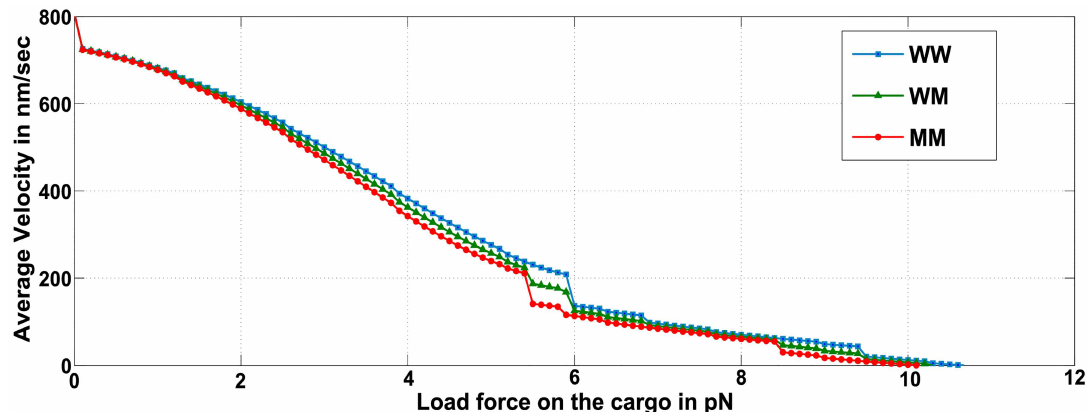
Fig 6. Average velocity with varying load forces on the cargo for ensembles WW, WM and